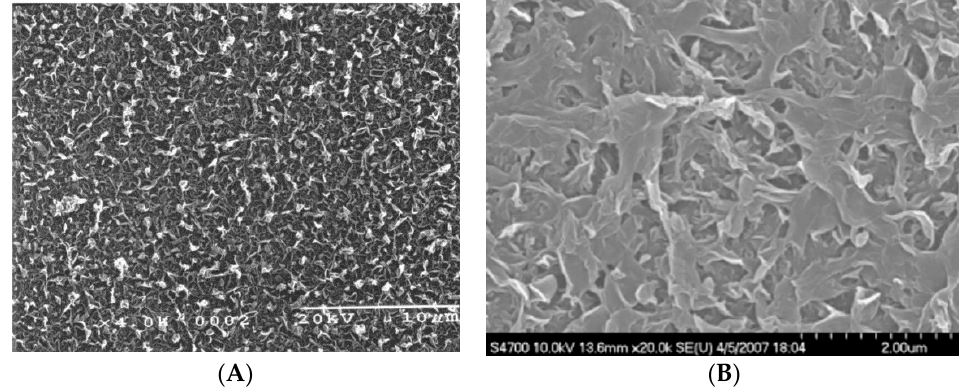
Figure 2. Scanning electron micrograph images demonstrating. surface roughness of polyamide membranes. ( A ) scale = 10 microns; courtesy of Mark Wilf. ( B ) scale = 2 microns; courtesy of Eric M.V. Hoek (reprinted with permission of Elsevier B.V.) [40].